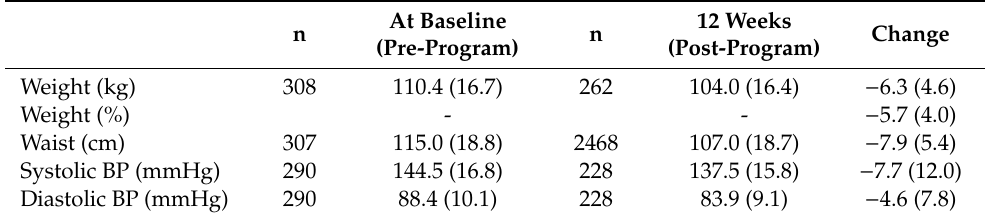
Table 4. Physical measures at start (baseline) and end (post-program) of routine deliveries of FFIT in nine clubs in England (mean [standard deviation SD]). At n